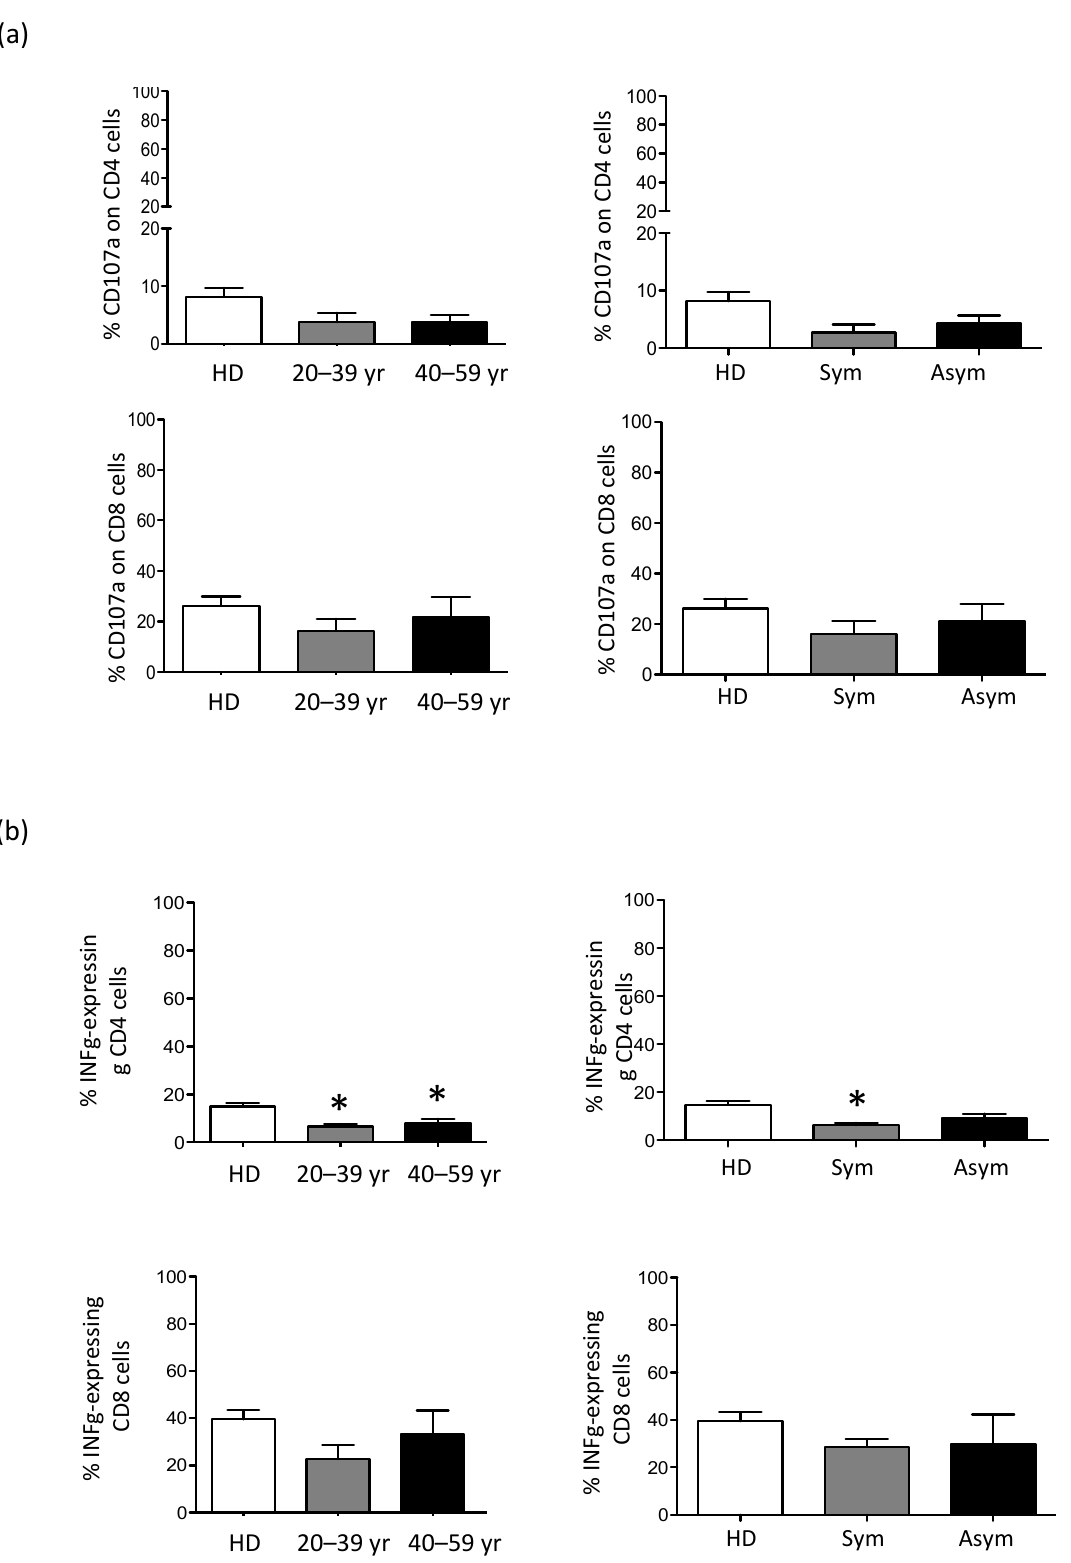
Figure 3. Functional analysis of CD4+ and CD8+ T cells. ( a ) Evaluation of CD4+ and CD8+ T cells capacity to upregulate the CD107a on cellular surface or ( b ) to produce INF γ after stimulation. Results from X-CGD carriers are showed in consideration of age and symptomatology and compared with n = 28HDs. Statistical significance was evaluated using one-way ANOVA with Dunnett’s post-test, considering: * p < 0.05.